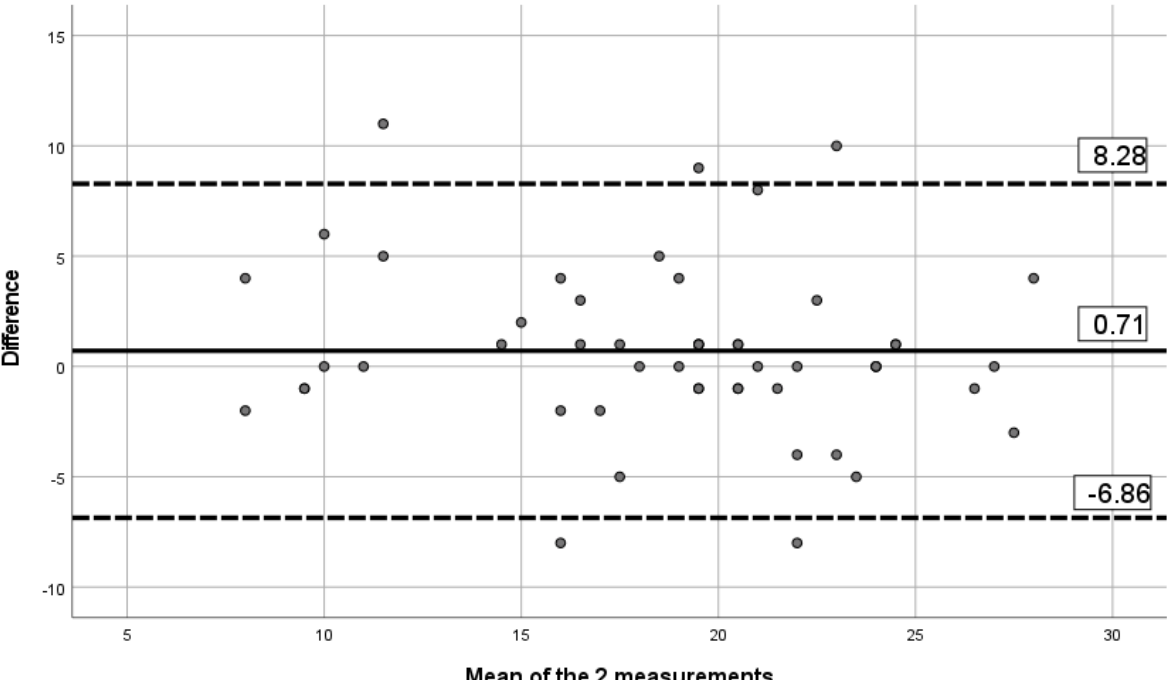
Figure 2. Bland-Altman limits for the Brief Pain Inventory severity subscale between the 2 assessments using the app.